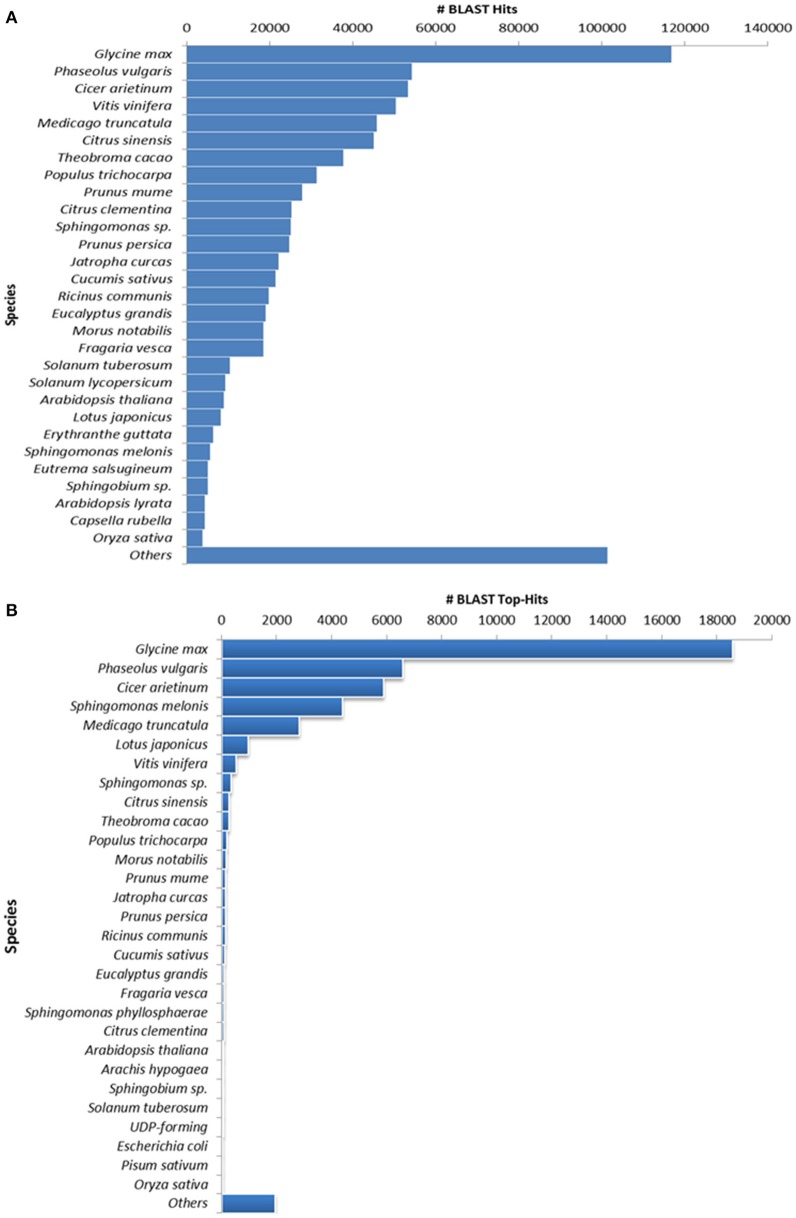
Species distribution results of guar leaf transcriptome. (A) By accounting all BLASTX hits and (B) Top hit species distribution based on BLASTX alignments.